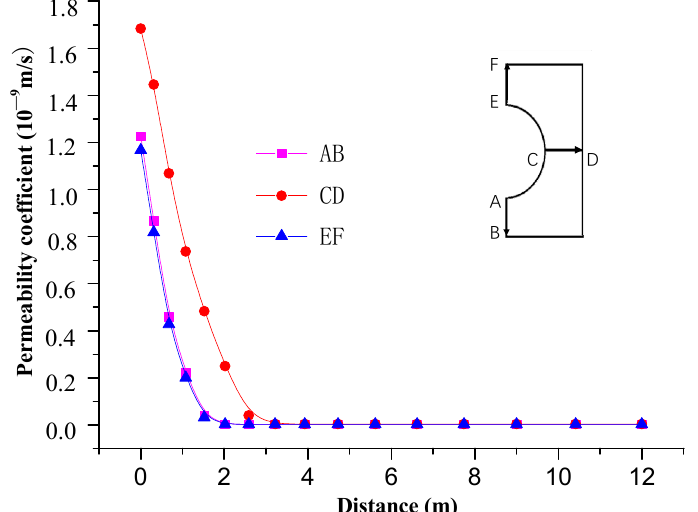
Figure 13. Distribution of permeability coefficient at different locations of roadway.